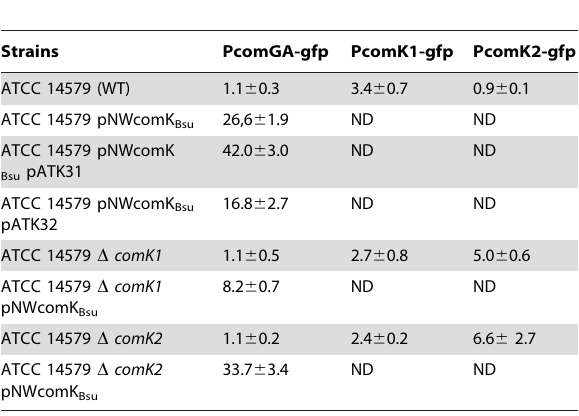
Table 2. Expression of the reporter gene ( gfp ) under different promoters.